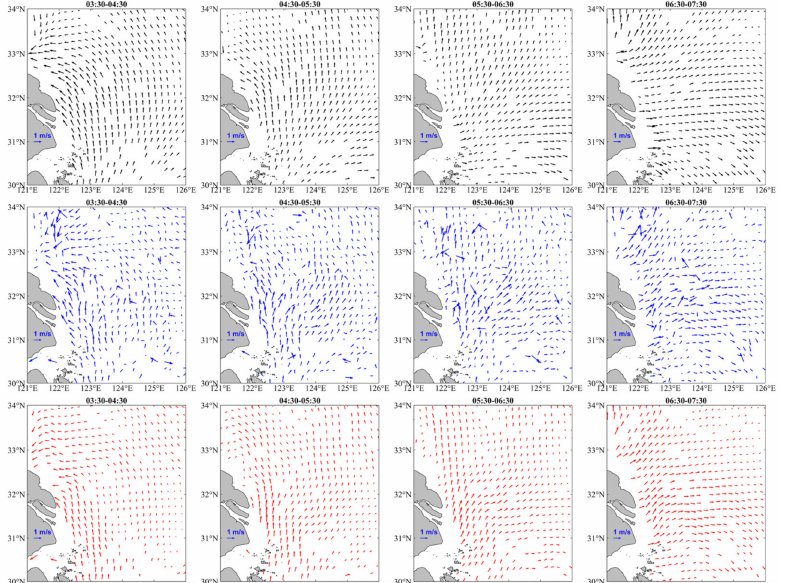
Figure 5. Surface currents from OSU model (top), MCC (middle) and MCC+MOI (bottom) for four GOCI image pairs at 03:30–04:30 UTC, 04:30–05:30 UTC, 05:30–06:30 UTC and 06:30–07:30 UTC on 13 May